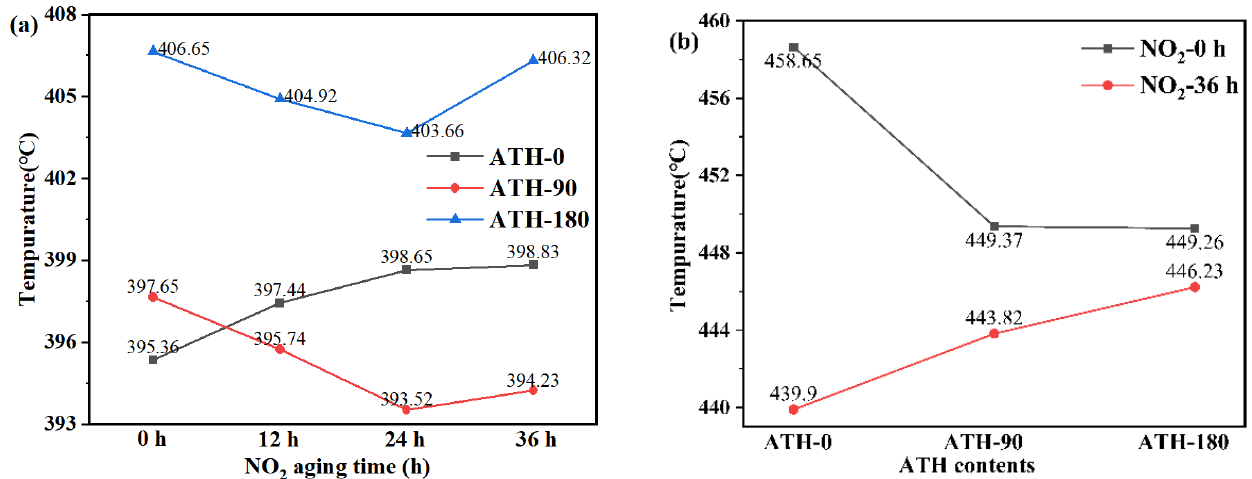
Figure 10. The initial decomposition temperature curves of PDMS ( a ) and the maximum decomposition rate temperature curves of PDMS ( b ).